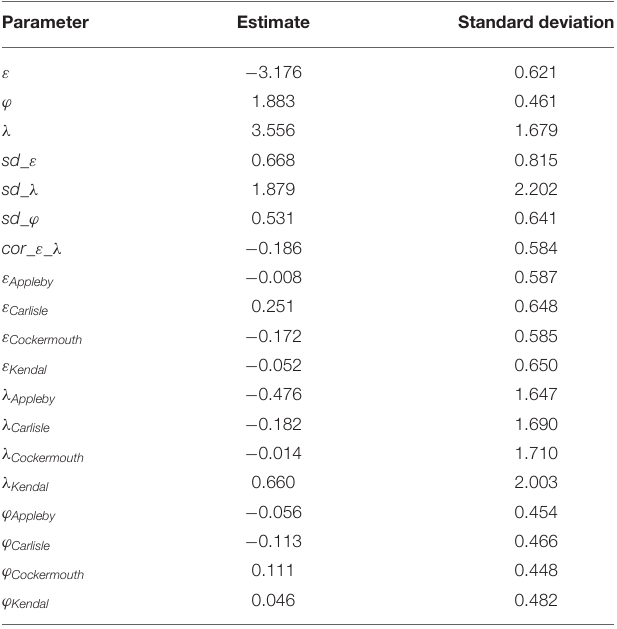
TABLE 3 | Model parameters estimate and standard